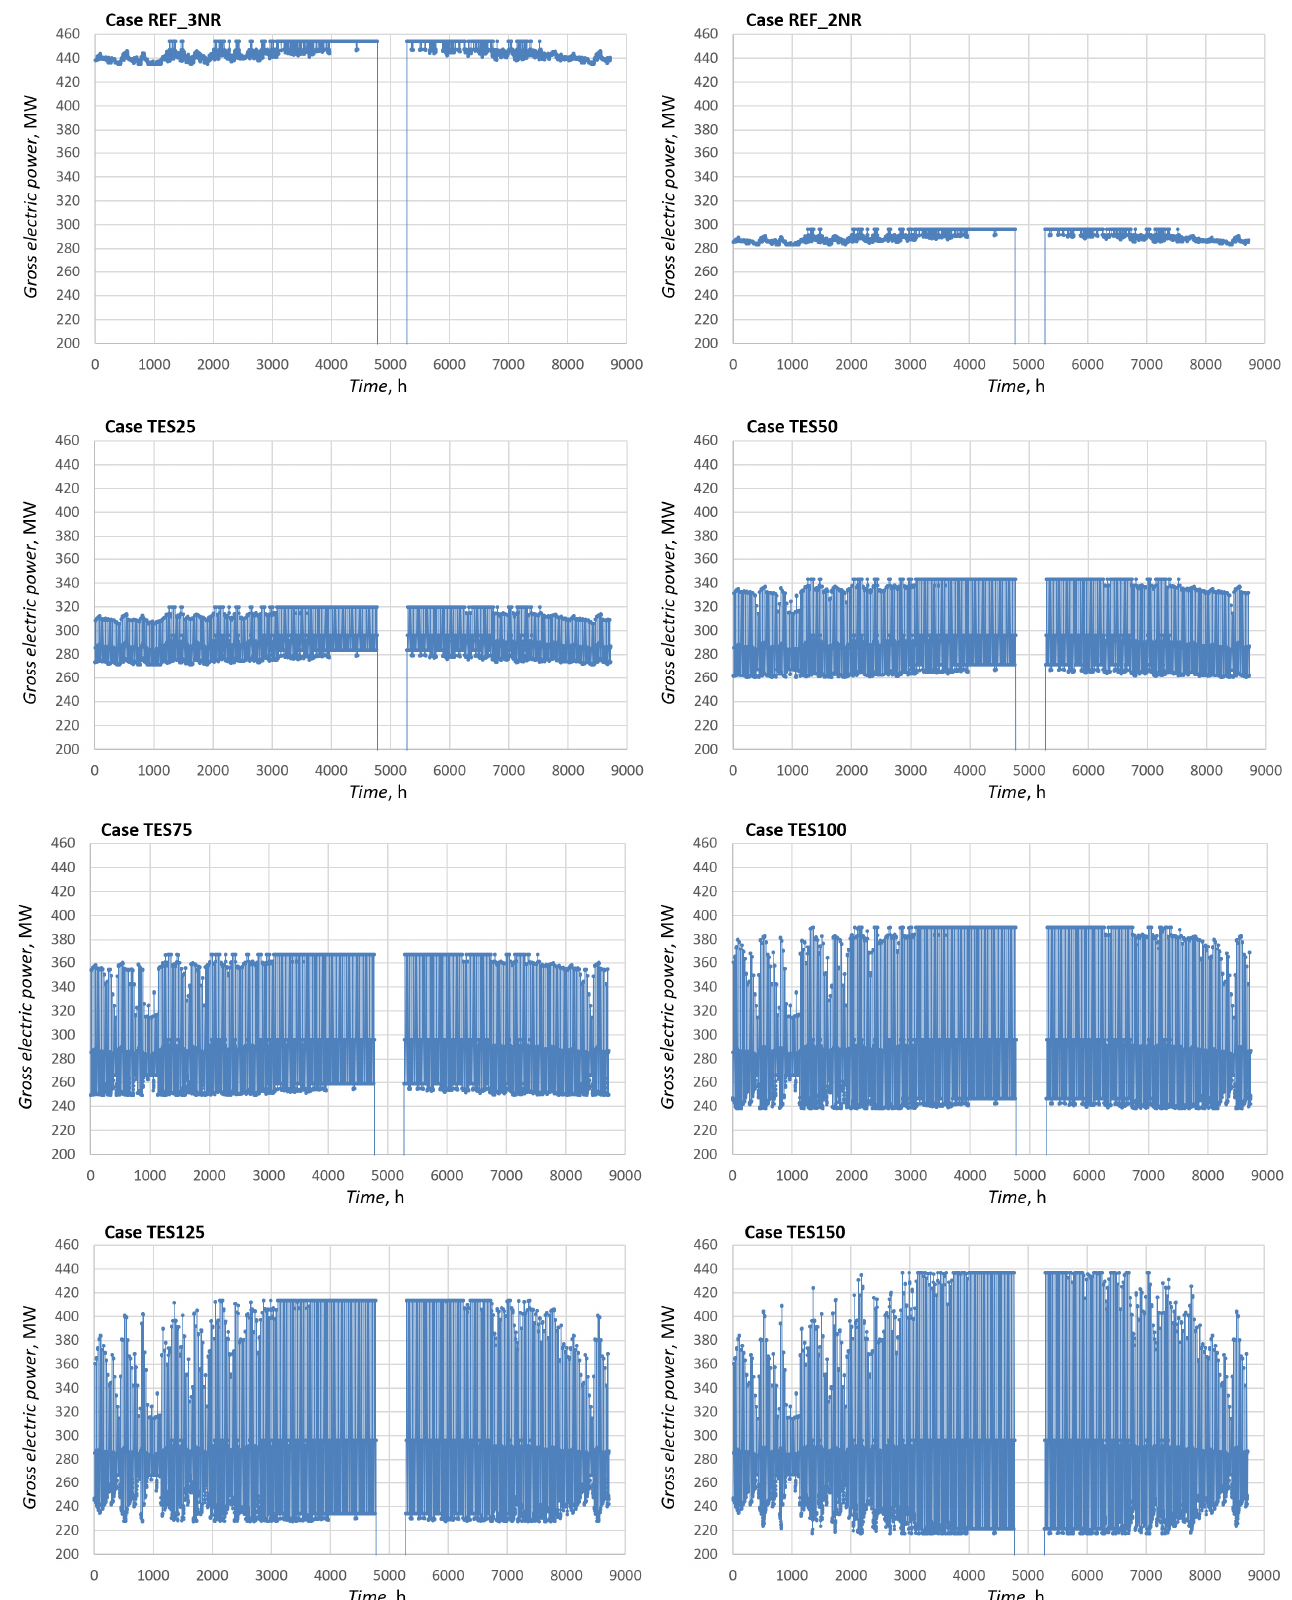
Figure 11. Thermal capacity of TES system as a function of time for reference year for all analyzed cases where TES is used.